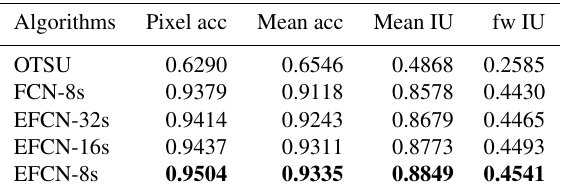
Table 4. Comparison of cloud segmentation results of different al- gorithms on diurnal and nocturnal ASI images. The enhanced per- formance values are highlighted in bold